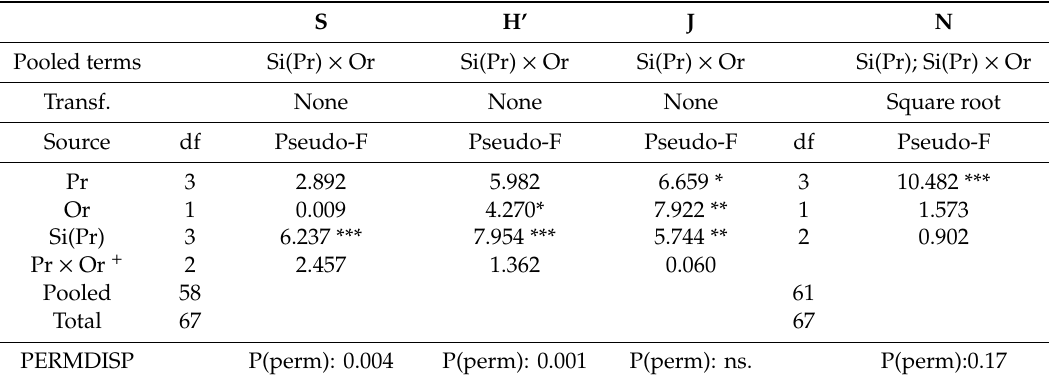
Table 5. Univariate analyses of variance of macrofouling assemblages across “Pressure” levels (Pr), “Origin of biofilm” (Or) and “Sites” (Si(Pr)) after 15 weeks of panel deployment. N: Percentage